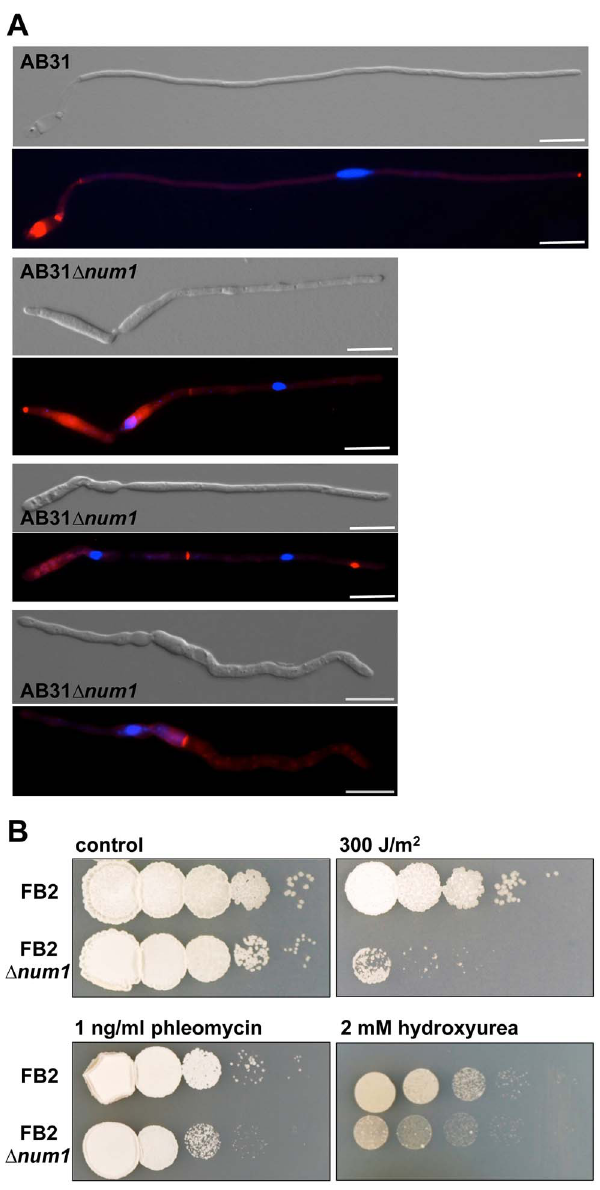
Figure 3. Num1 influences the cell cycle and cell division as well as the cellular response to DNA damage. ( A ) Induction of the bE1/bW2 heterodimer in wild-type cells (AB31) induces a G2 cell cycle arrest, resulting in hyphae with a single nucleus positioned in the tip compartment. In AB31 D num1 , 18% of the hyphae contain more than one nucleus, usually separated by a septum or a septum-like chitin structure, which is not always visible in the DIC-channel (see also Figure S6). In some cases, delocalized septa give rise to compartments that are devoid of any nuclei (bottom panel). Filaments were stained with DAPI and Congo Red, which effectively stains chitin in fungal cell walls [26], to visualize nuclei and septa within the same hypha. Scale bars: 10 m m. ( B ) Sensitivity of an FB2 D num1 deletion strain to DNA-damage in comparison to wild-type cells. Serial 10-fold dilutions were spotted on complete medium containing the indicated DNA-damage inducing supplements, or subsequently irradiated with 300 J/m 2 UV light (254 nm), respectively. Pictures were taken 2–3 days after incubation at 28 u C.